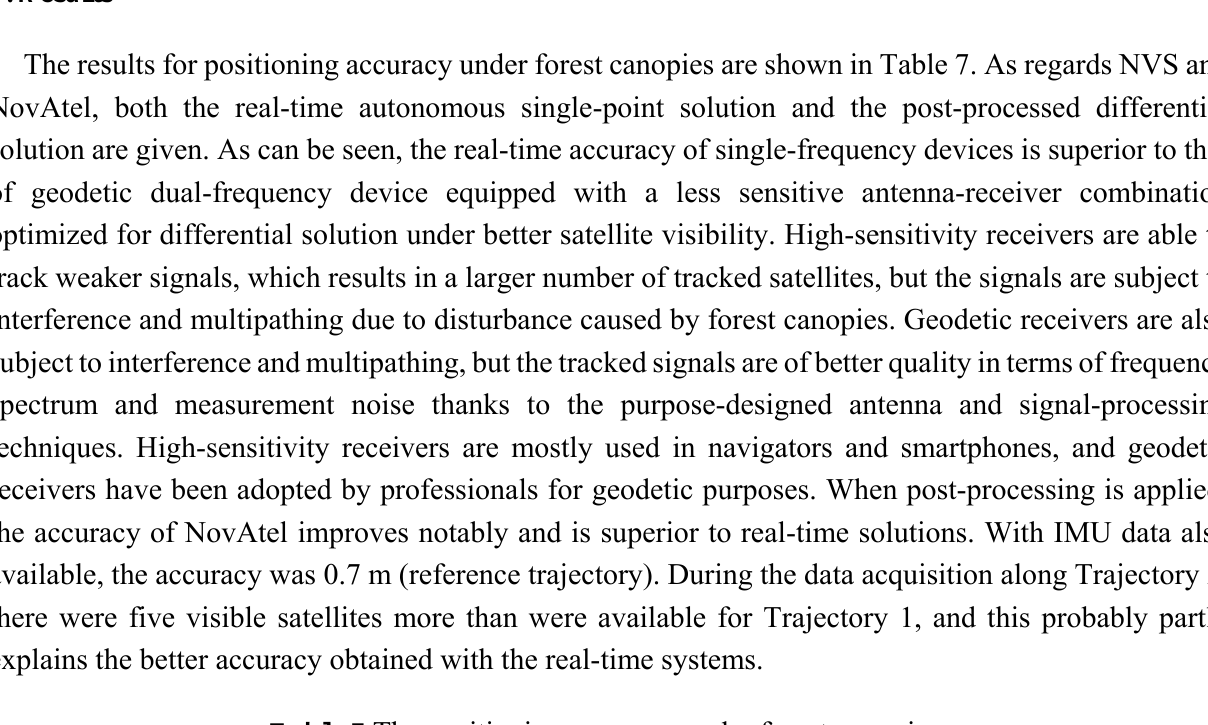
Table 7 The positioning accuracy under forest